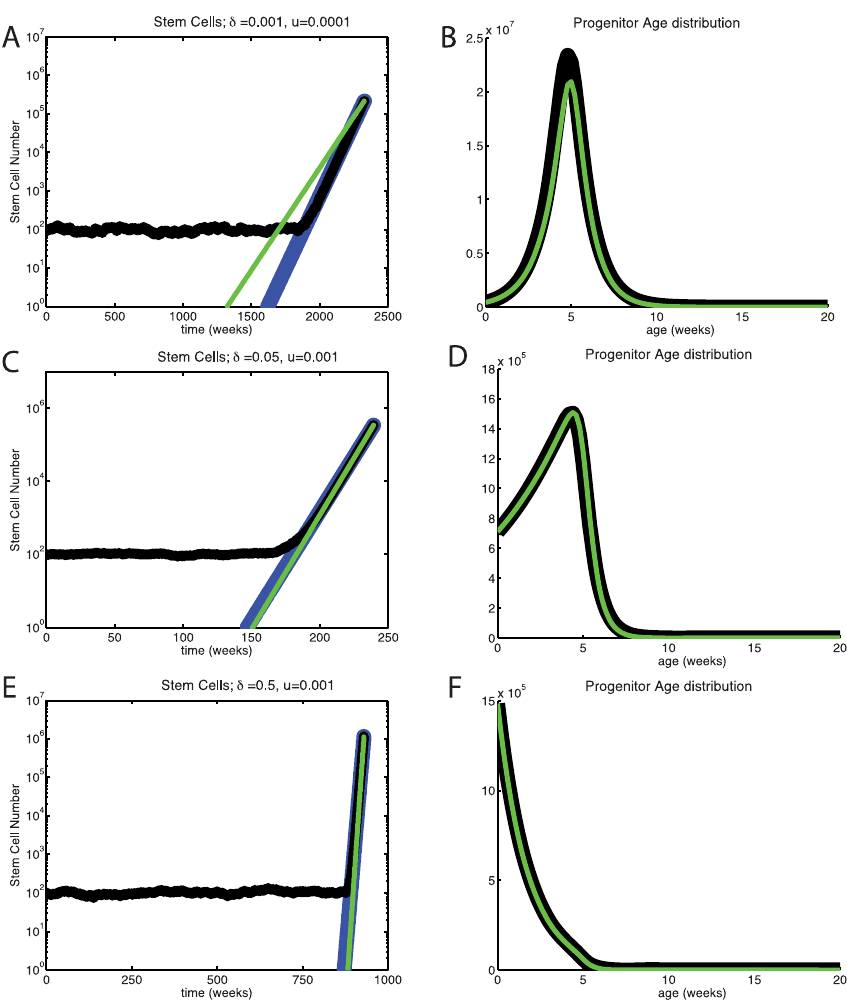
Figure 5. Exponential growth given varying stem cell population size and dedifferentiation. Total number of stem cells (A, C, E) and corresponding final progenitor age distributions (B, D, F) are shown in black. Also shown are best exponential fits of the growth rate (blue) and our semi-analytic solution given by Eq. (18) (green). In all panels the probability of asymmetric stem cell division g ~ 0 and the mean reversion parameter is j ~ 1 .